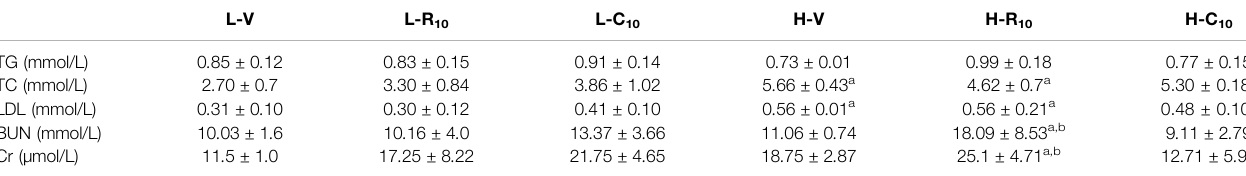
TABLE 2 | Biochemical characteristics of mice 12 weeks after intragastric administration rosiglitone or